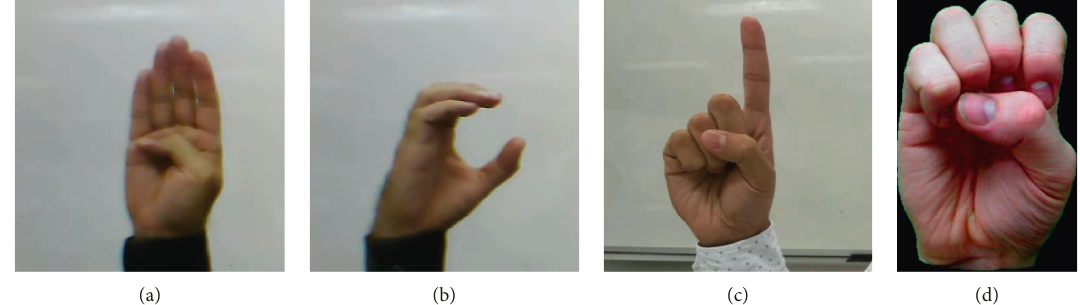
Figure 5: Samples from the adopted dataset used, from left to right: gestures b, c, d, and